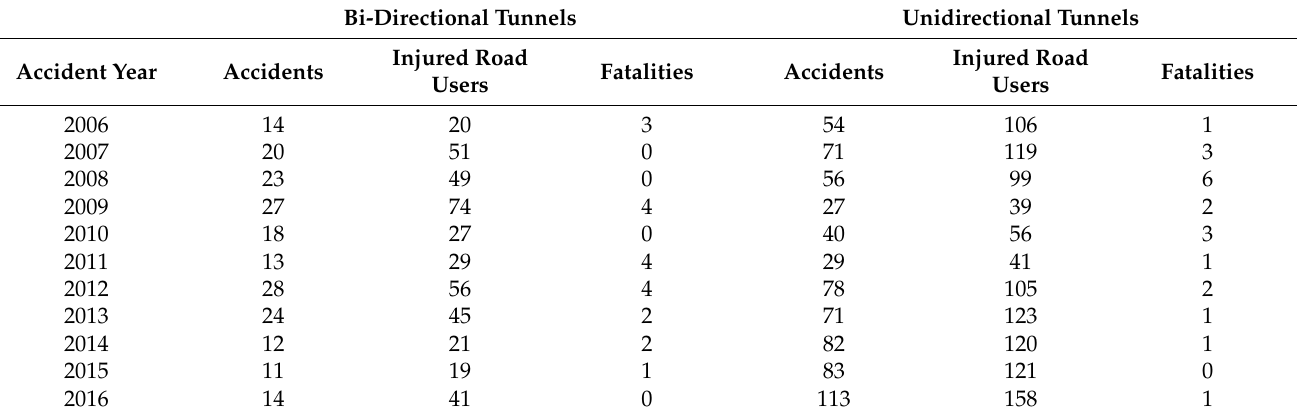
Table 2. Accidents in tunnels with a length of more than 500 m on motorways and expressways in Austria separated in bi-directional and unidirectional tunnels